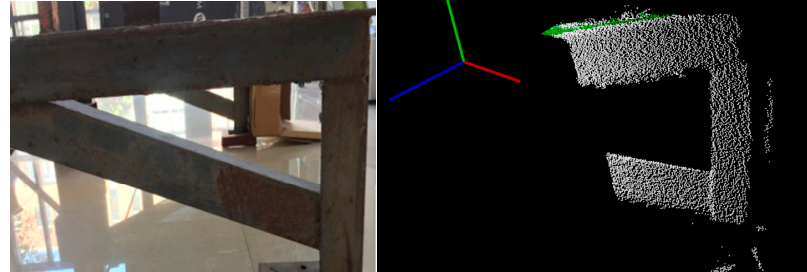
Figure 4. Three-dimensional (3D) point cloud of a part of the bracket acquired by the rotating two-dimensional (2D) Light detection and ranging (LIDAR) sensor.